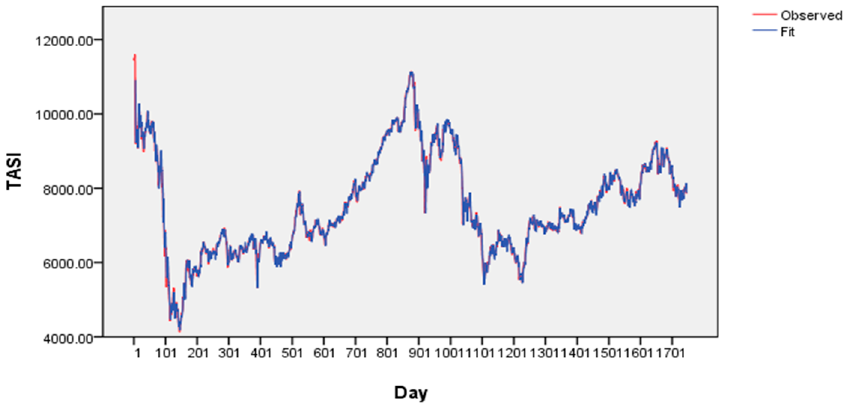
Figure 5. Estimating TASI using ARIMA (0,1,14) with the explorer method.